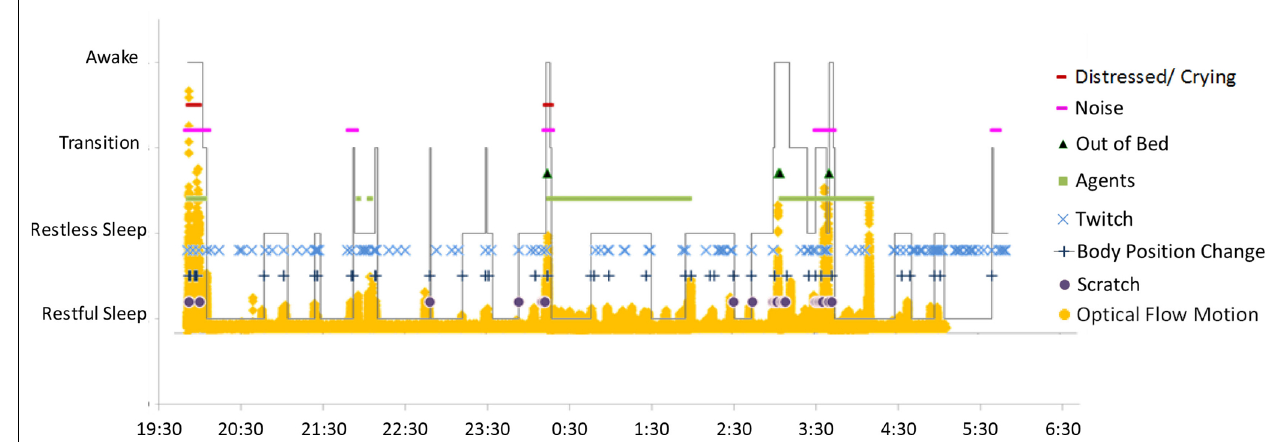
FIGURE 7 | Comparison between Optical Flow © and HVS-hypnogram . This diagram overlays the HVS-hypnogram ( Figure 5 ) and the Optical Flow © diagram ( Figure 6 ) to show the close correspondence between sleep state (and number of sleep events) and movement